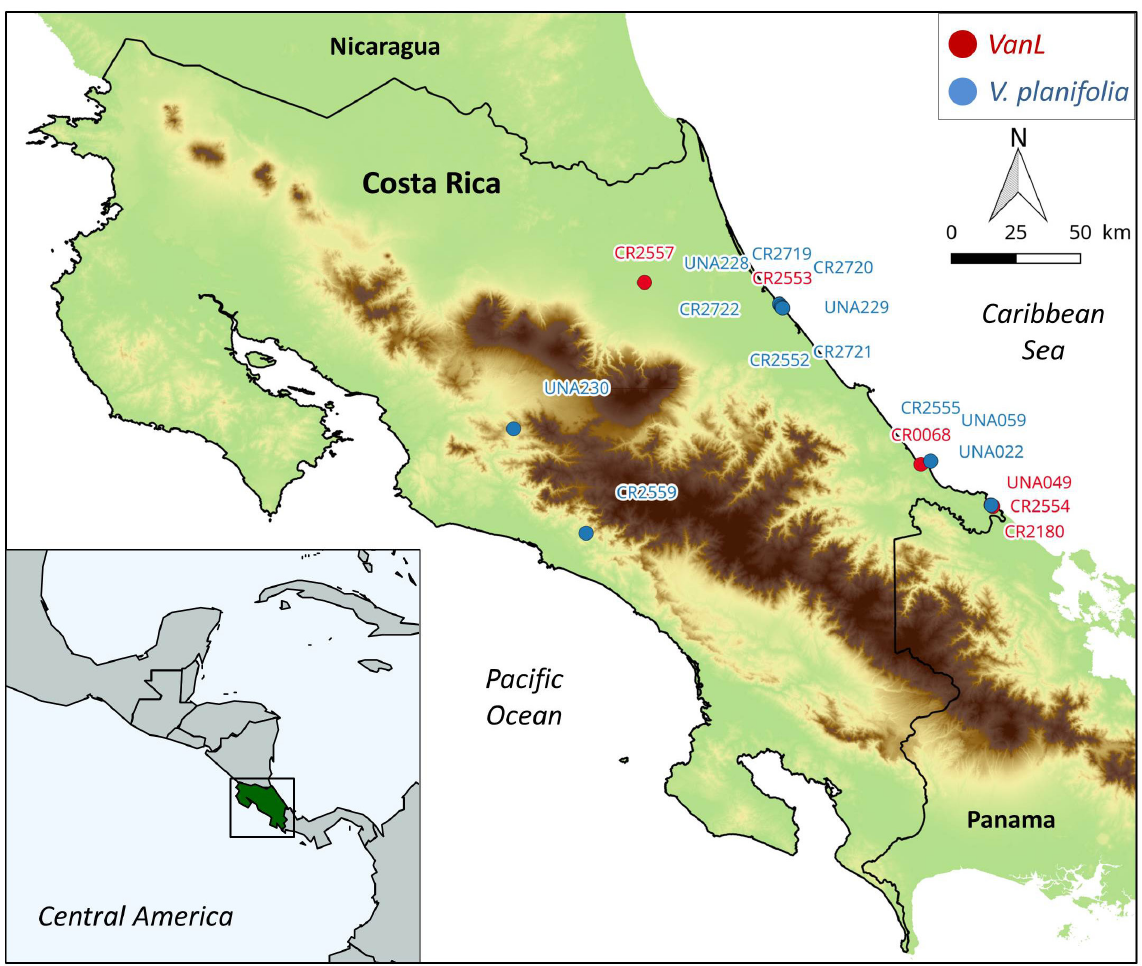
Fig. 1. Localization of Vanilla sotoarenasii M.Pignal, Azofeifa-Bolaños & Grisoni sp. nov. (VanL) and V. planifolia Jacks. ex Andrews samples collected in Costa